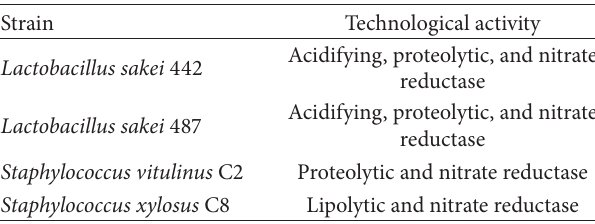
Table 1: Indigenous bacterial strains used as starter cultures in this